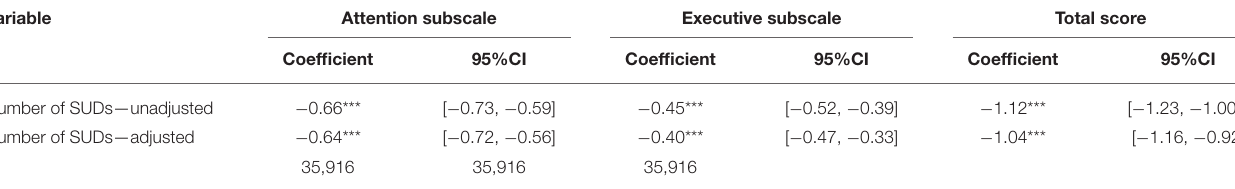
TABLE 2 | Linear regression estimating the association between the number of substance use disorders and Executive Function Index scores.